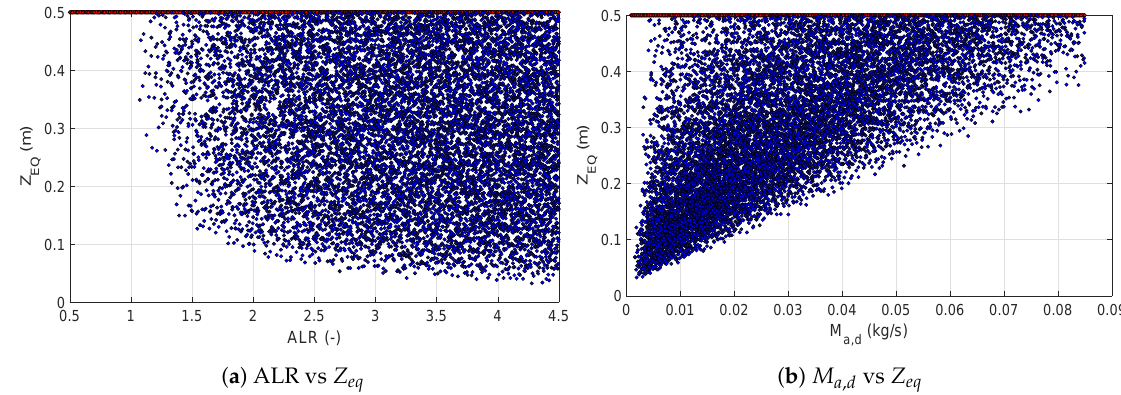
Figure 8. Scatter plots of equilibrium length Z eq with respect to ALR ( a ) and the mass flow rate of the drying air M a , d ( b ). The red dots indicate the values at non-equilibrium conditions, while blue dots represent the values at